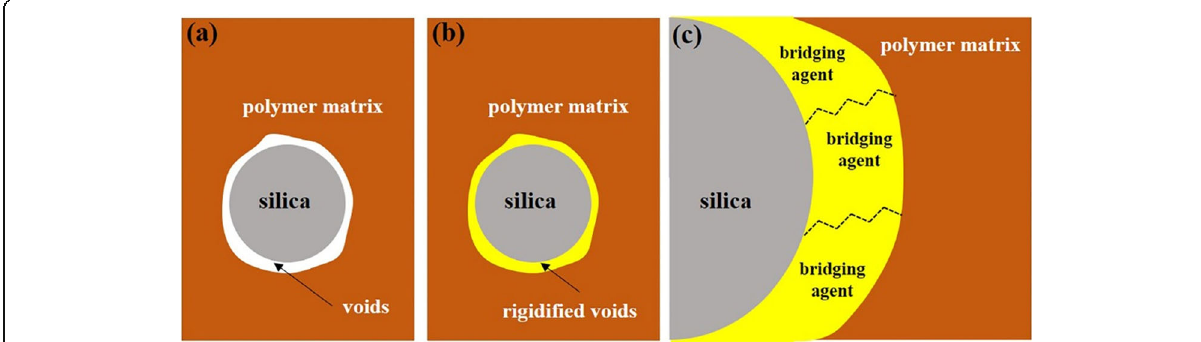
Fig. 2 Interphase properties of MMMs containing silica: ( a ) void formation, ( b ) rigidification of void, ( c ) bridging of the filler and polymer matrix upon surface modification, adapted from Goh et al. [54]